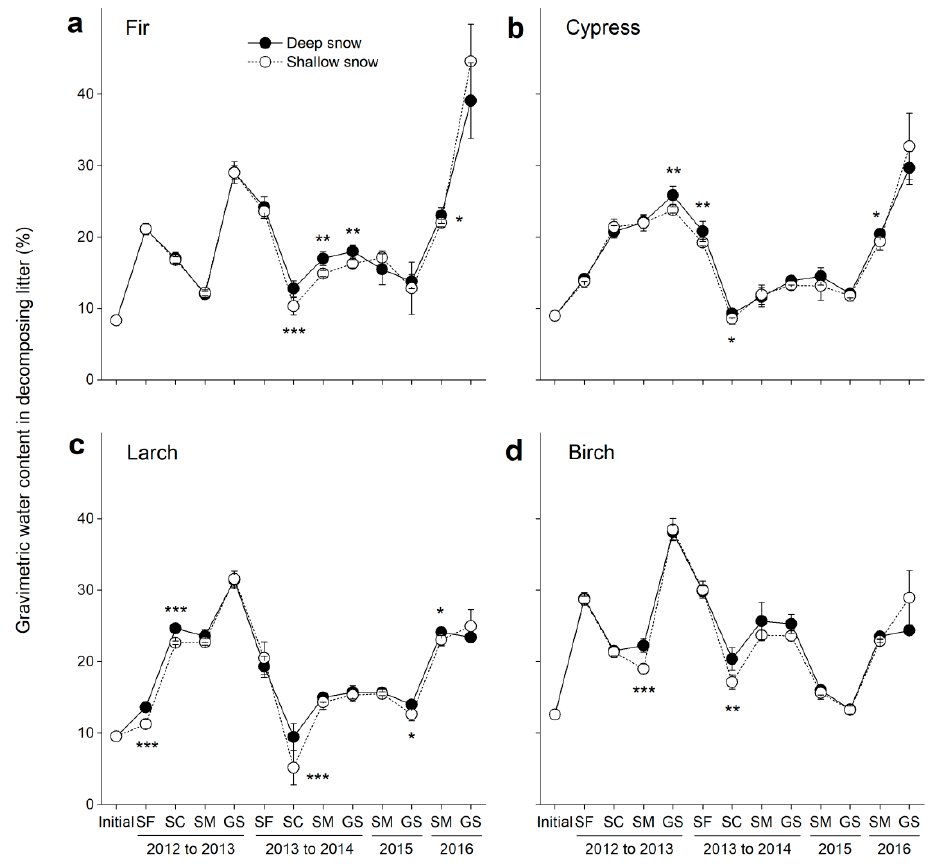
Figure 3. Gravimetric water contents ( ± SE, n = 6) in decomposing litter in the deep and shallow snow plots. ( a ) Fir, ( b ) cypress, ( c ) larch, and ( d ) birch. SF: snow formation stage, SC: snow coverage stage, SM: snowmelt stage, and GS: growing season. * p < 0.05, ** p < 0.01 and *** p <